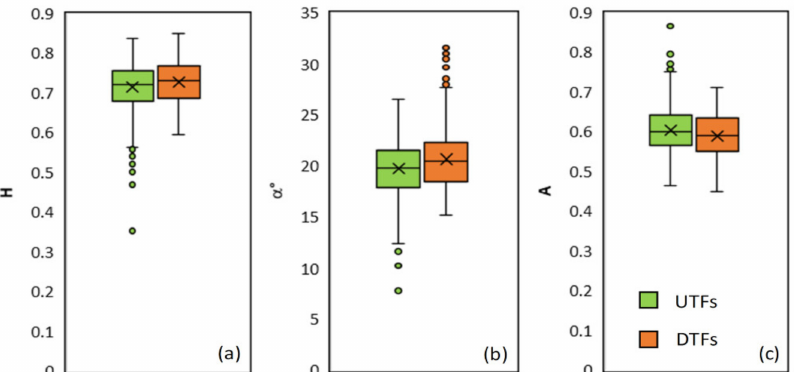
Figure 5. Boxplots of H- α -A distributions for UTFs and DTFs. The boxplot values are from bottom to top, respectively, 5th, 25th, 50th—cross is mean value—75th, and 95th percentiles. ( a ) Entropy pixel distribution; ( b ) alpha angle pixel distribution; ( c ) anisotropy pixel distribution.